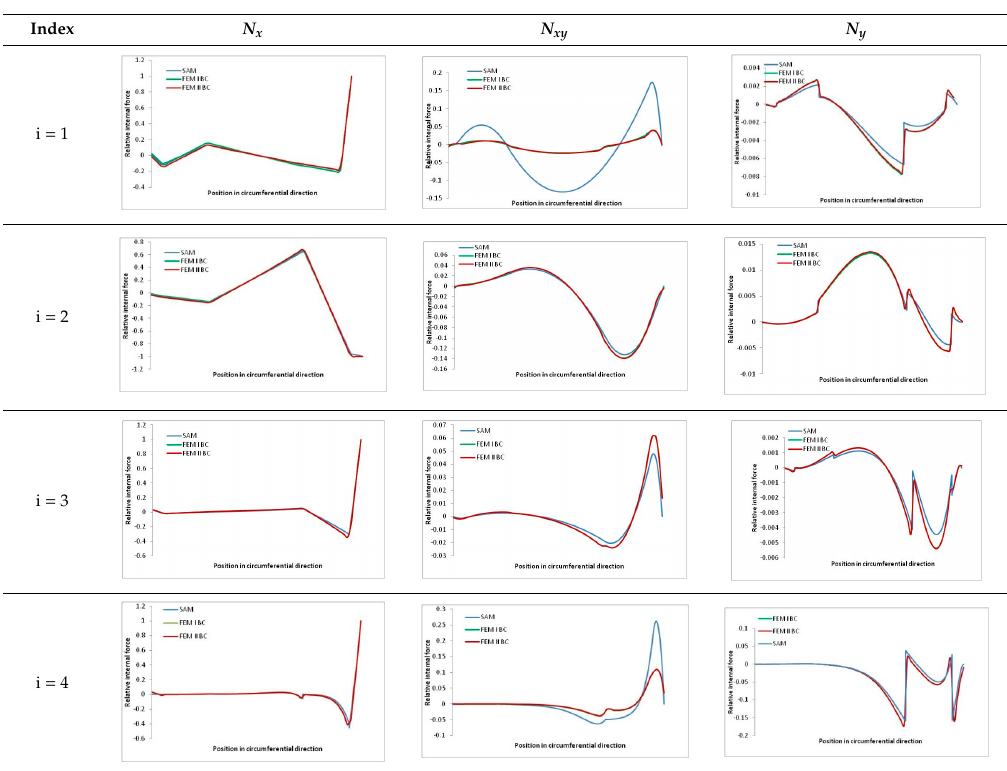
Table 8. The distribution of internal forces N x , N y and N xy for the LC–2 beam.